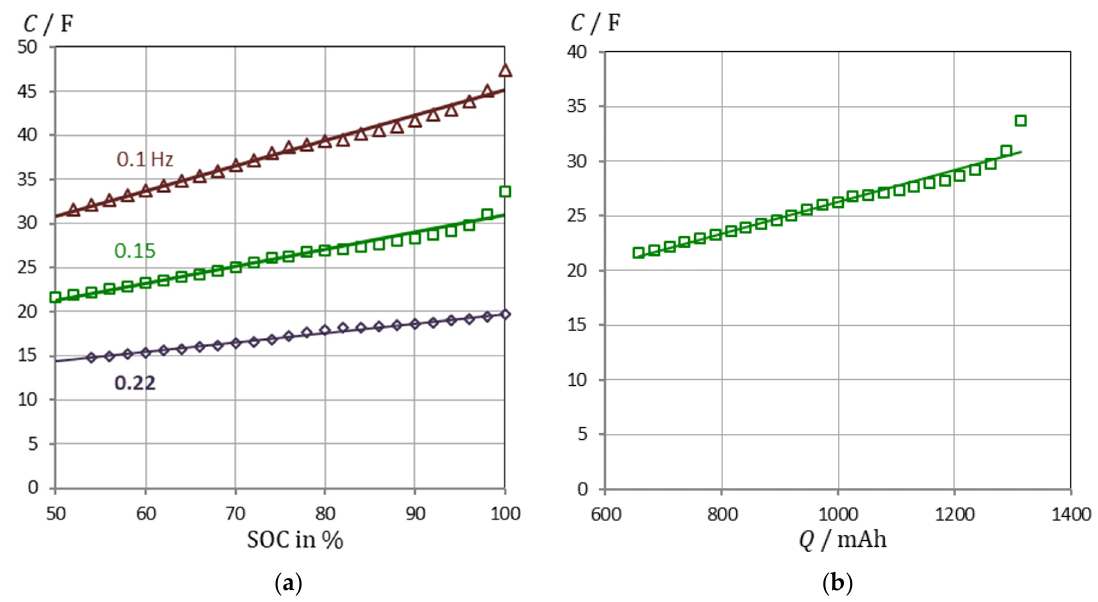
Figure 5. ( a ) State-of-charge monitoring of a VoltSolar LFP cell (1.5 Ah) using capacitance at selected frequencies. Example: C /F = 0.1925·SOC + 11.64 at 0.15 Hz. SOC = Q / Q 0 is based on Ah counting. EIS measurements were performed from 100% to 50% SOC in 2% steps. ( b ) Linear relationship between capacitance and battery capacity: C = 14.65 · Q + 11.64 (fit quality: 95.3%).